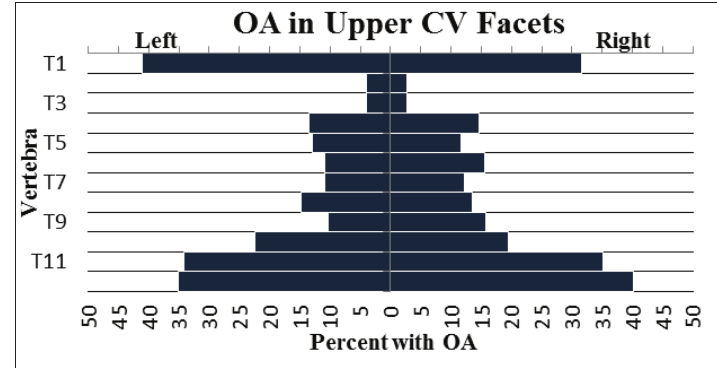
Figure 1: Prevalence of OA in superior CV joints for all skeletons combined.